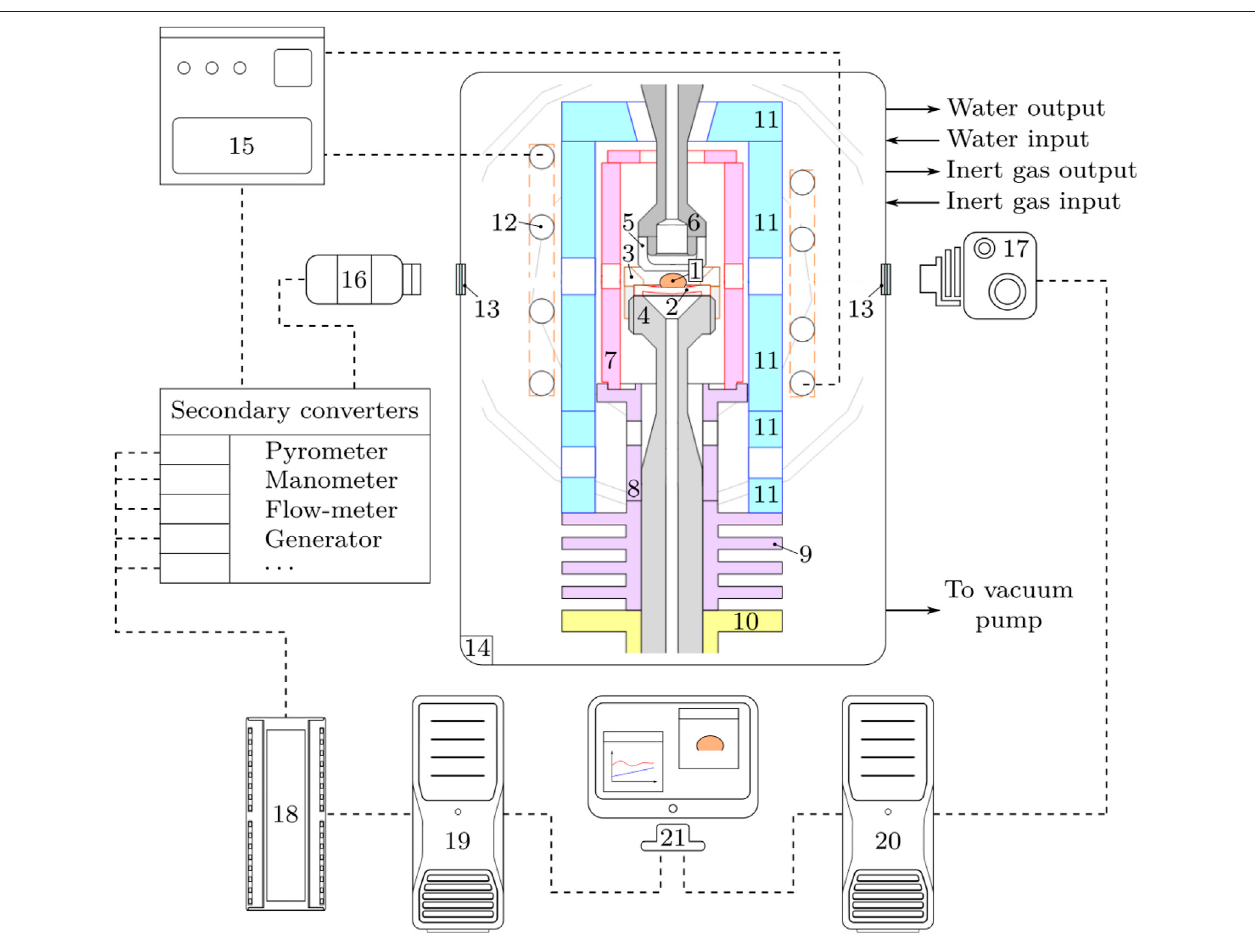
FIGURE 12 | Overall layout of VITI-GFL con fi guration (Grishchenko and Piluso, 2011). 1: drop; 2: lower diffuser; 3: screwing system; 4: lower diffuser holder; 5: upper diffuser;6:upperdiffuserholder;7:susceptor; 8:susceptorholder;9: fi ns;10:globalsupport; 11:thermalshield;12:inductor;13:windows;14:VITIcon fi nement vessel; 15: generator; 16: pyrometer; 17: high-speed camera; 18: data bus; 19: data acquisition computer; 20: imaging computer; 21: monitoring.